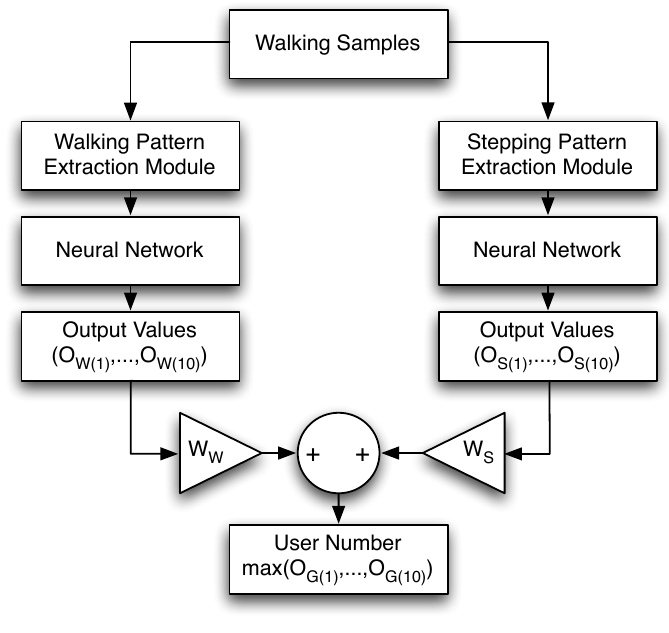
Figure 14. A flow chart of fusion at the matching score level for gait